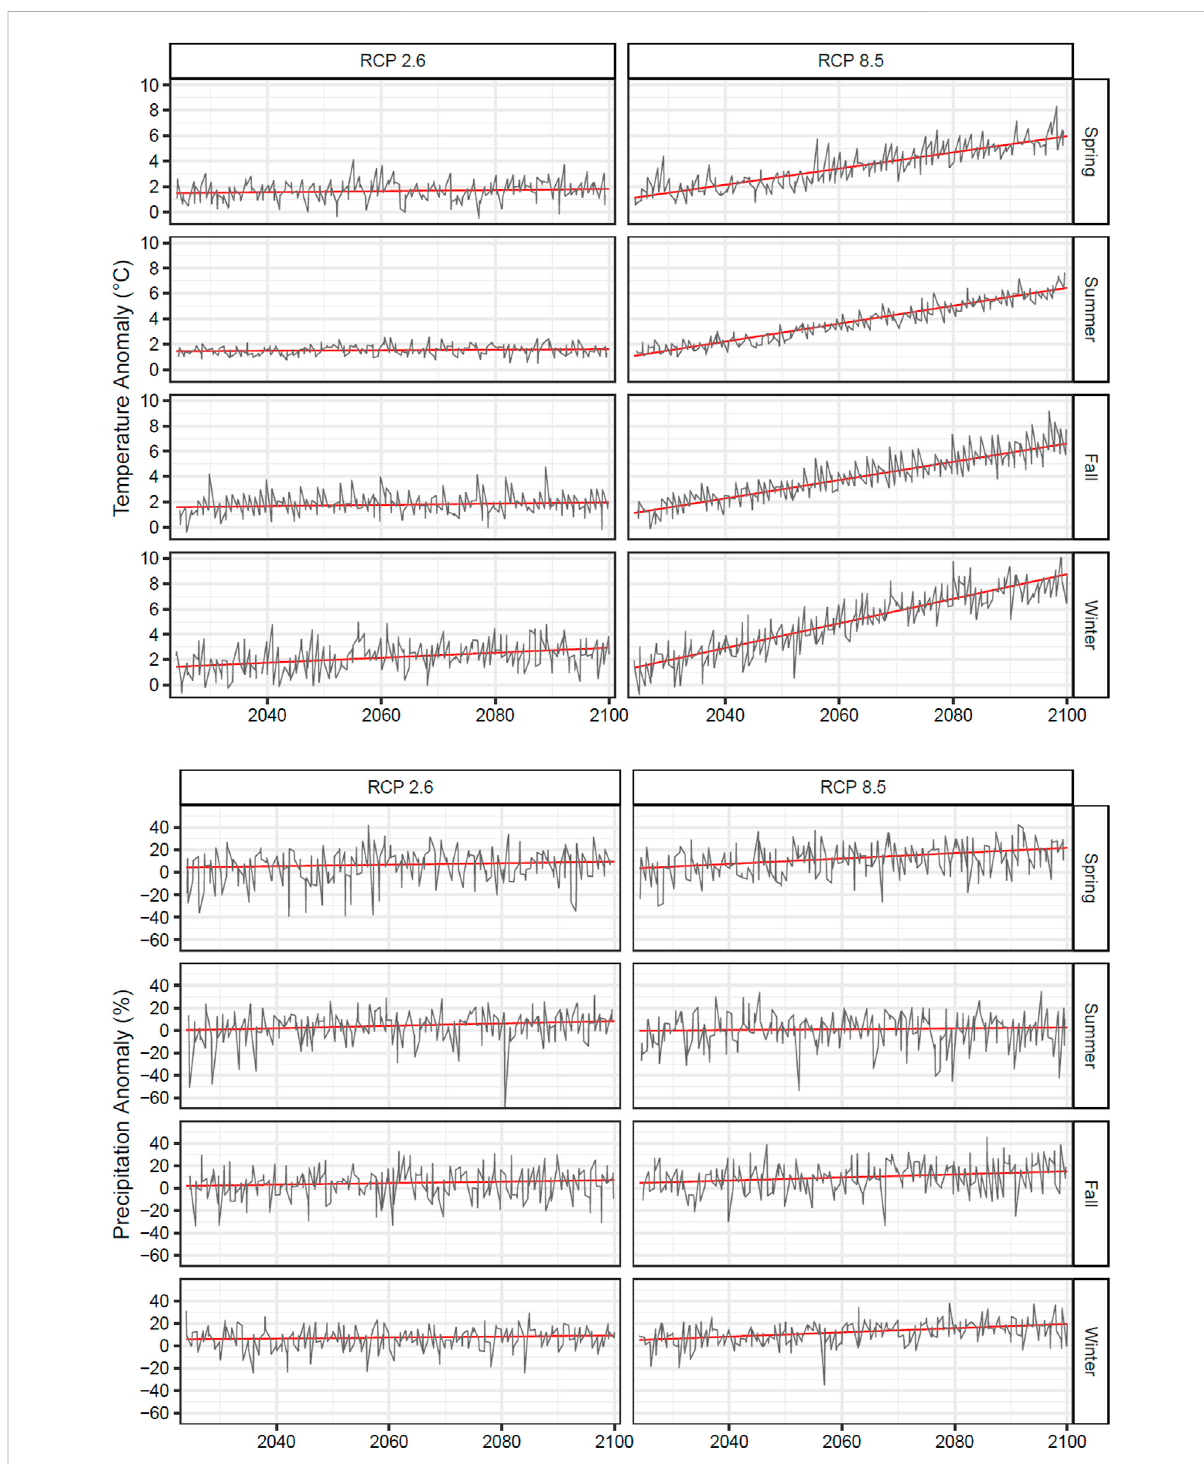
FIGURE 4 Seasonal temperature (top) and precipitation (bottom) anomalies for climate change scenarios relative to 1986 –